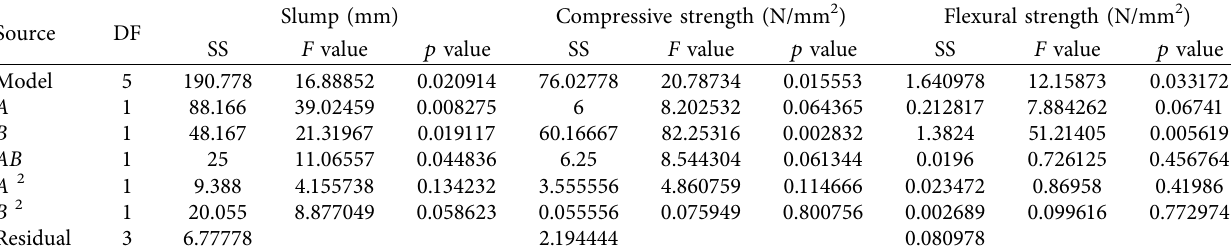
Table 4: Results of ANOVA.